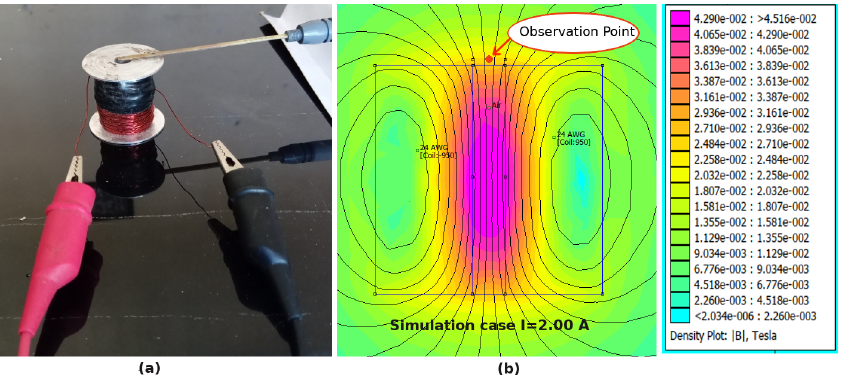
Figure 2. FEMM verification setup, ( a ) measurement setup ( b ) FEMM Simulation contour